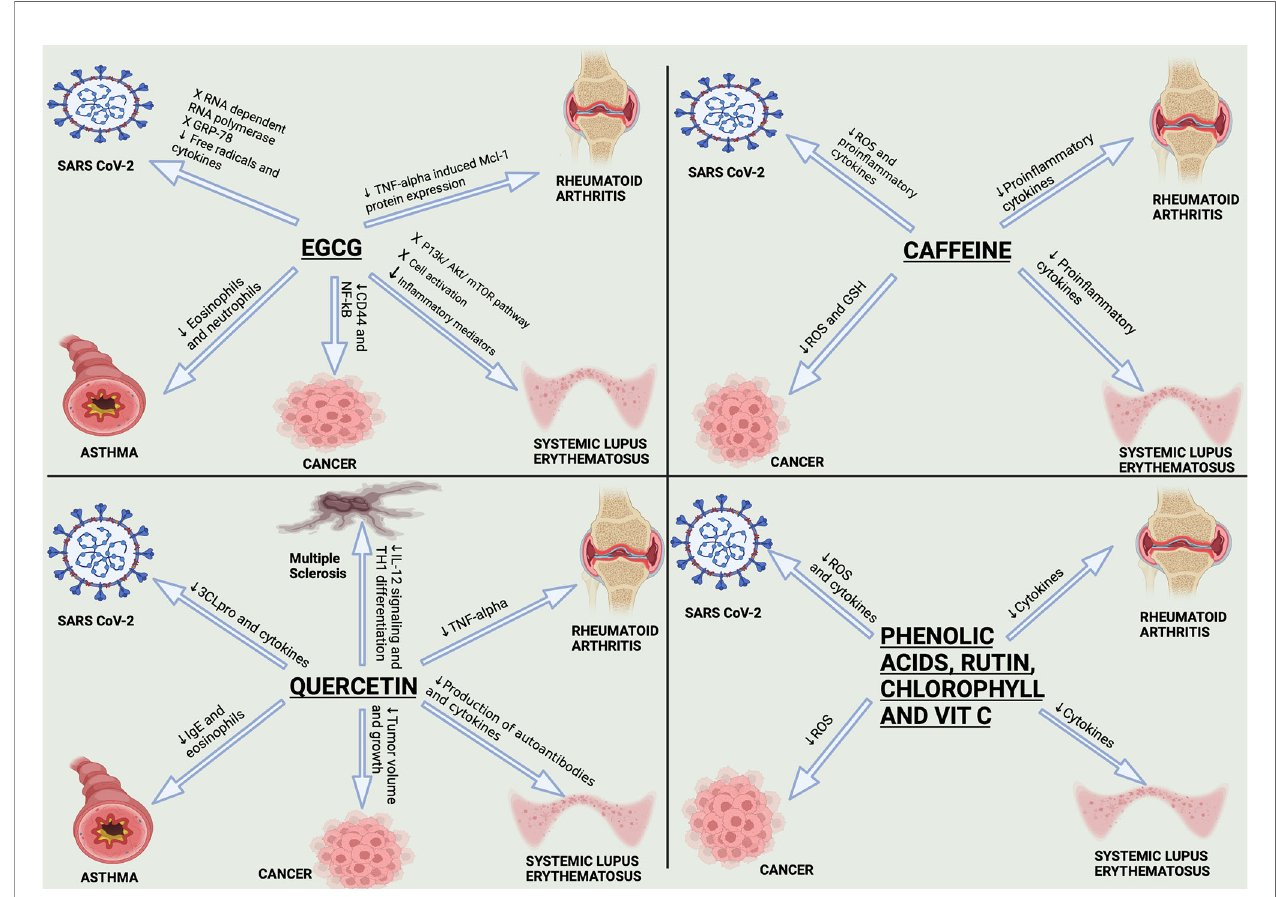
FIGURE 6 | Matcha bene fi cial effects in protecting cancer and autoimmune patients from SARS-CoV-2 infection. This fi gure highlights the dynamic constituents of matcha and its bene fi cial effects in preventing SARS-CoV-2 infection and also ameliorating SARS-CoV-2-positive patients. A special focus on cancer and autoimmune patients is presented. Patients who have caught SARS-CoV-2 were found to have a decrease in IFNs; thus, EGCG stimulates the expression of both TLR4 and TLR2, and this helps in reducing the pro-in fl ammatory cytokines and the cytokine storm. Since the viral nucleic acid activates the RIG-1 that increases IFN-1, EGCG showed to act as a RIG-1 inhibitor. In addition, EGCG has an antioxidant effect by neutralizing the free radicals and boosting the detoxi fi cation enzymes. Moreover, quercetin is a potent immunomodulatory in SARS-CoV-2, as it has many functions such as antiviral activity, platelet aggregation inhibition, and inhibition of proin fl ammatory mediators like Lipoxygenase (LOX) and Phospholipase A2. Rutin has an antioxidant and anti-in fl ammatory activity; thus, it is useful in the management of COVID-19. The chlorophyll content in matcha has proven to be bene fi cial due to its anti-in fl ammatory and antioxidant effect, which assists to overcome the cytokine storm. Besides, caffeine has a potential anti-in fl ammatory effect by decreasing proin fl ammatory cytokines, and its antioxidant effect is due to reduction of ROS and increase of glutathione. In addition, Vitamin C greatly stimulates antiviral immune responses and reduces the lungs ’ in fl ammatory state. It is essential to highlight that the intake of matcha tea not only will manage COVID-19 symptoms but also can prevent the virus itselffrom infecting